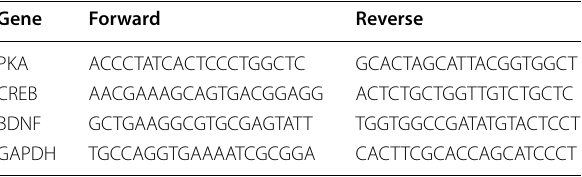
PKA protein kinase, CREB cAMP response element-binding protein, BDNF brain-derived neurotrophic factor, GAPDH glyceraldehyde- 3-phosphate dehydrogenase